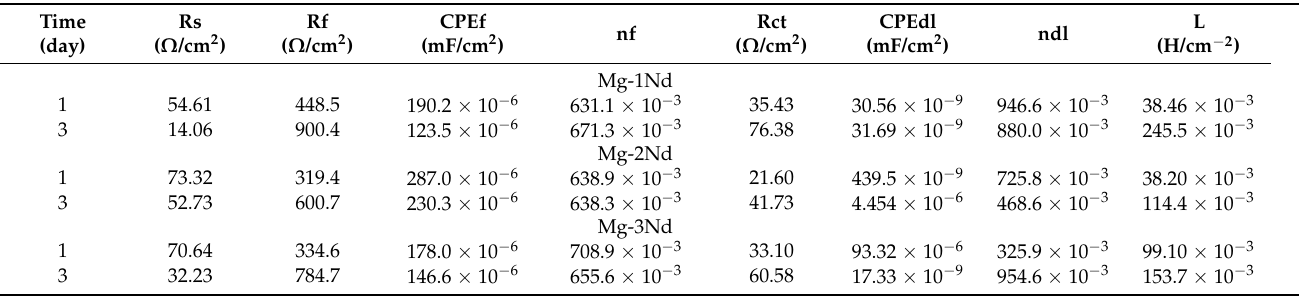
Figure 8. ( a ) Equivalent circuit diagram; ( b ) physical model of equivalent circuit. Table 3. EIS fitting results of F-state Mg-Nd